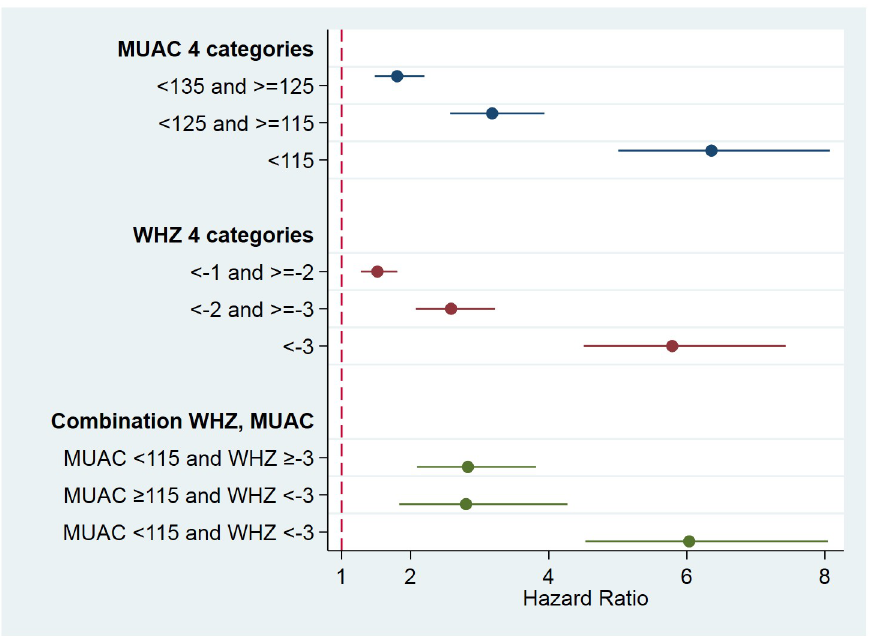
Fig 2. Hazard ratios with 95% CI resulting from Cox proportional hazard regression models for all measurements in children aged 6–59 months combined. The reference categories are � 135 mm for MUAC; � -1 Z-scores for WHZ; and MUAC � 115 and WHZ � -3 for the combination of indicators.